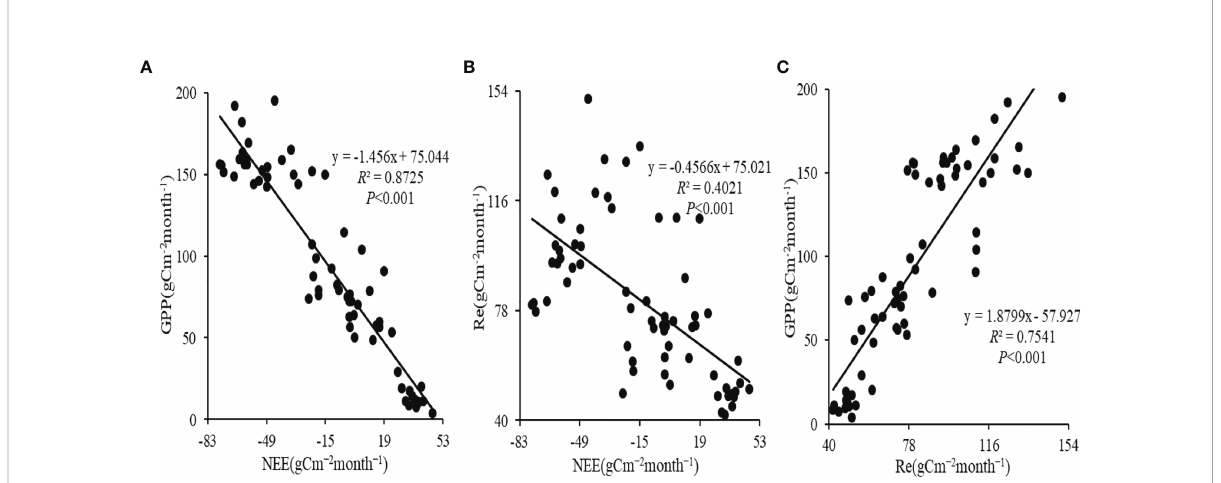
FIGURE 3 Linear regressions between monthly GPP and NEE (A) , linear regressions between monthly Re and NEE (B) , and linear regressions between monthly GPP and Re (C) of alpine wetland in the growing season for the period 2004-2016.